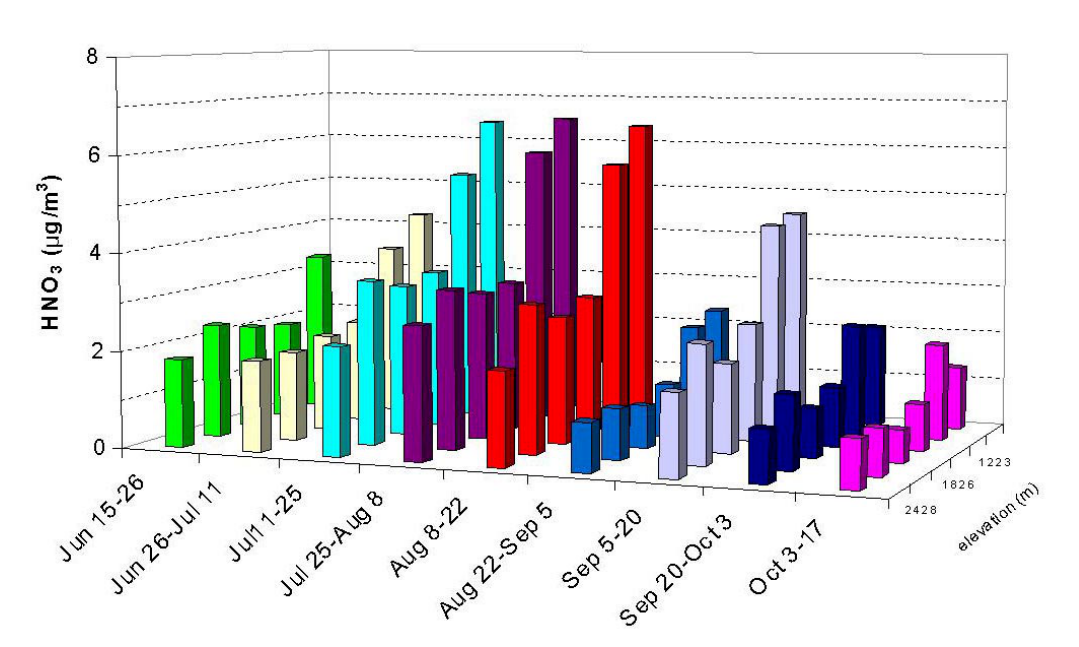
FIGURE 9. Concentrations of HNO 3 (µg m -3 ) determined with passive samplers exposed during 2-week long periods during summer